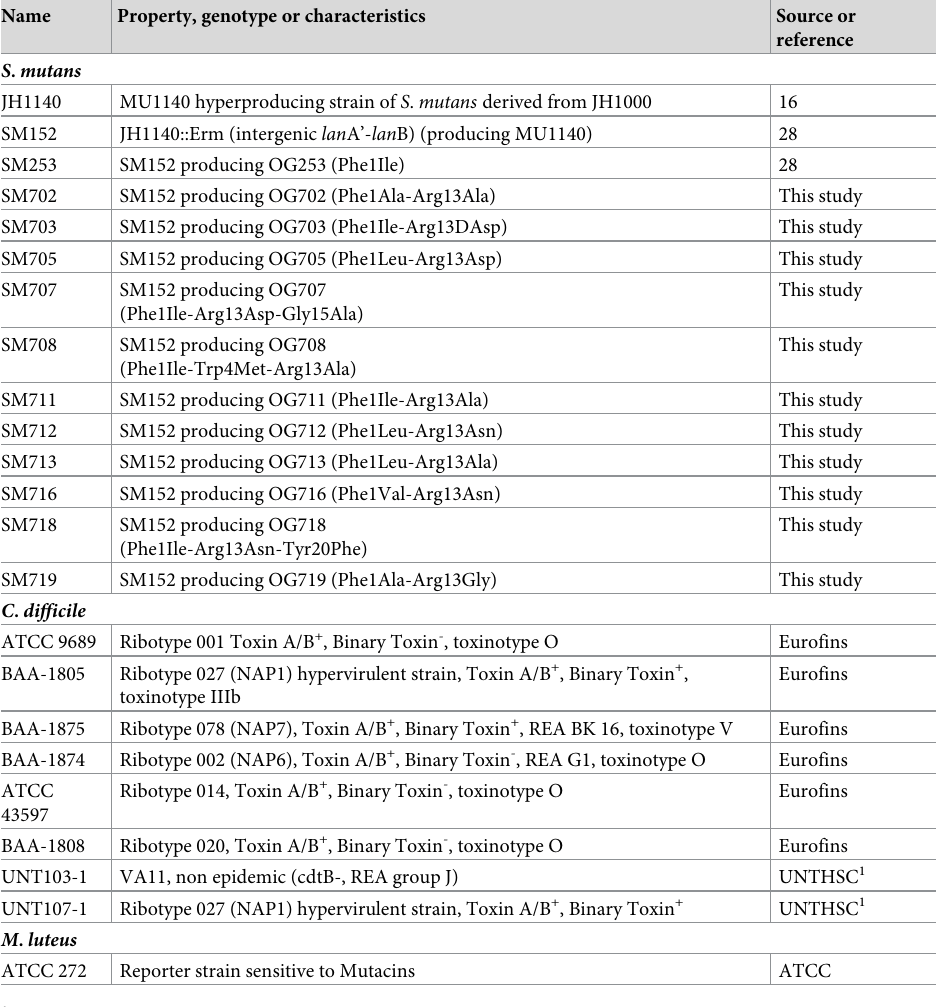
Table 1. Selected strains used in this